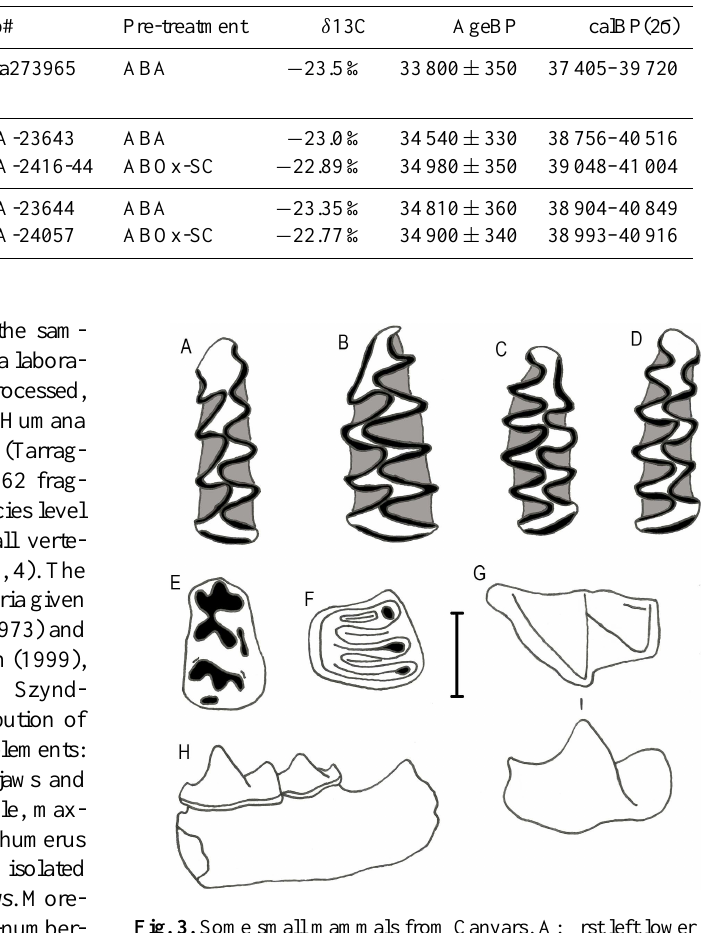
Table 1. Radiocarbon dates from Canyars. Ages (BP, before present) are calibrated with the OxCal 4.1.7 software (Bronk Ramsey, 1995) using the IntCal09 curve (Reimer et al., 2009).